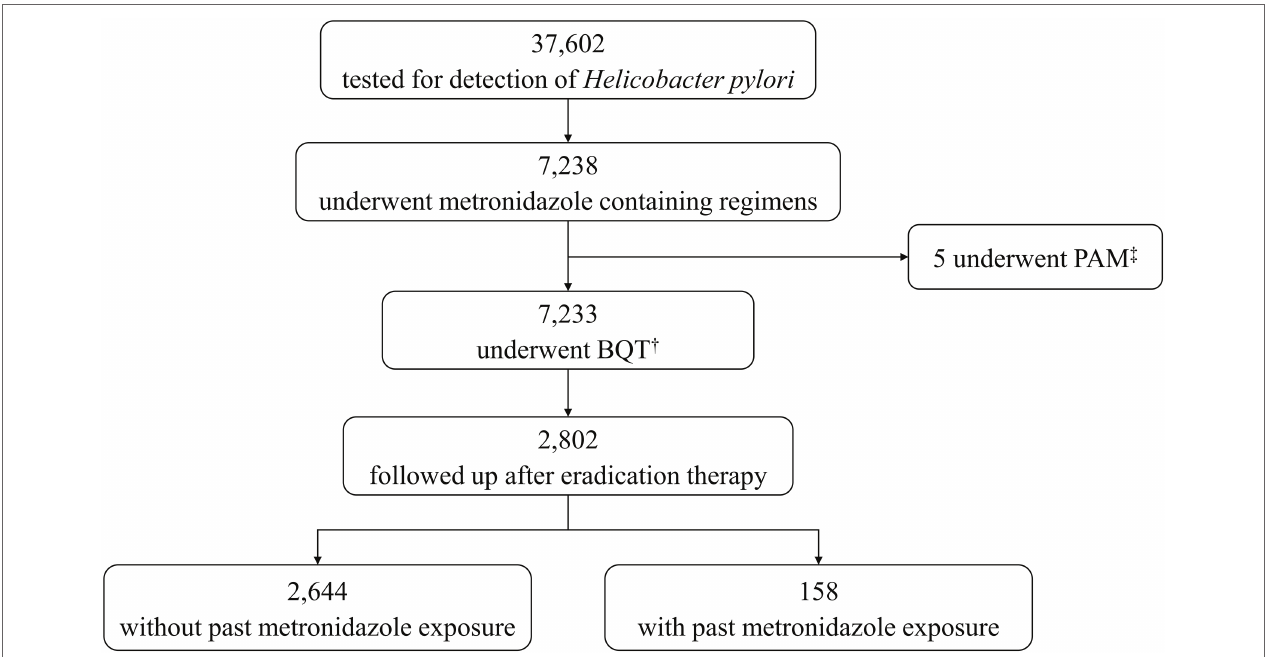
FIGURE 1 | Flow chart. † BQT, bismuth quadruple therapy, ‡ PAM, proton pump inhibitor, amoxicillin, and